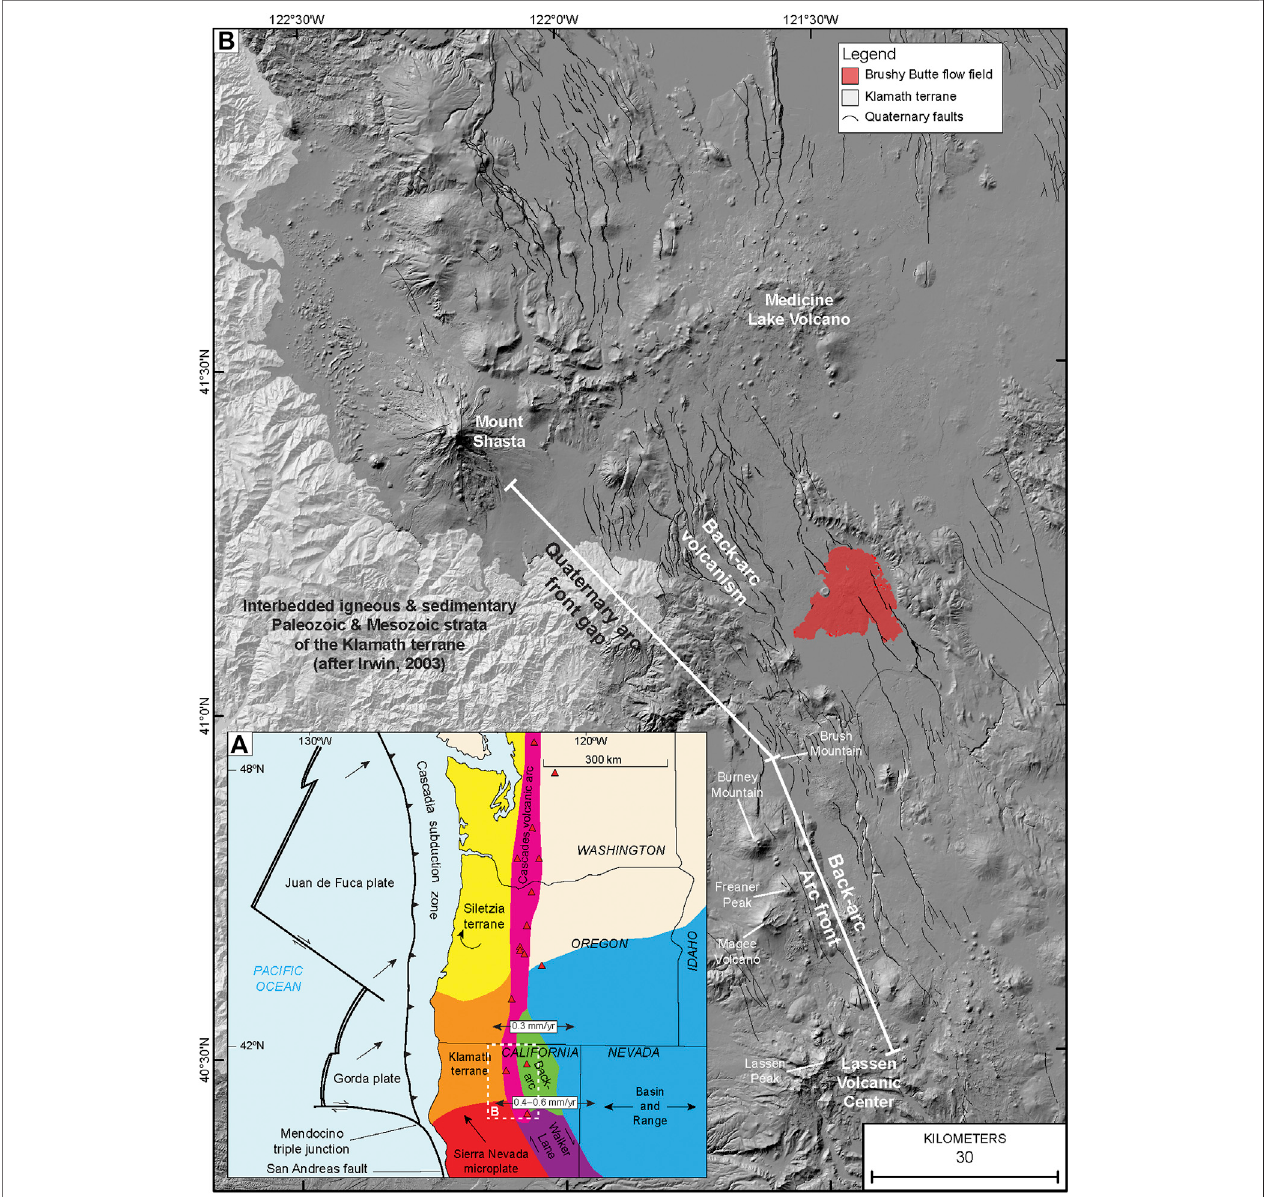
FIGURE 1 | (A) Tectonic setting of western North America, with red triangles denoting major volcanic centers. Dashed box is location shown in (B) . Arrows show directions of motion for parts of North America and subducting oceanic plates. (B) Shaded-relief terrain model (12 m-resolution TanDEM-X digital elevation model from the German Aerospace Center, 2017) of the southernmost part ofthe Cascades volcanic arc showing the long-lived, active volcanic centers of Mount Shasta, Medicine Lake Volcano, and the Lassen Volcanic Center. The Brushy Butte fl ow fi eld in the back-arc is shown in red, as are the abundant back-arc north-northwest-striking normal faults (from the U.S. Geological Survey Quaternary fault and fold database of Machette et al., 2004). Mesozoic sedimentary and igneous rocks of the Klamath terrane are present west of Quaternary volcanic rocks (after Irwin, 2003).